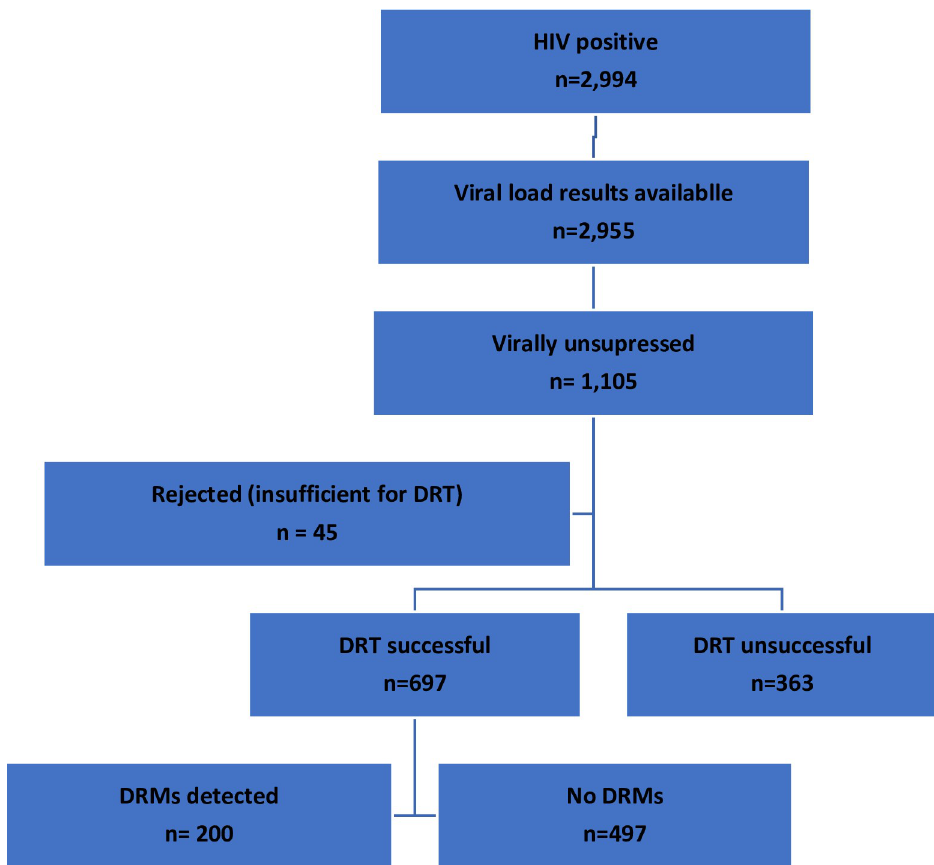
Fig 1. Samples tested for HIV drug resistance, South Africa, 2017. DRT- Drug Resistant Testing; DRMs- Drug Resistant Mutations.